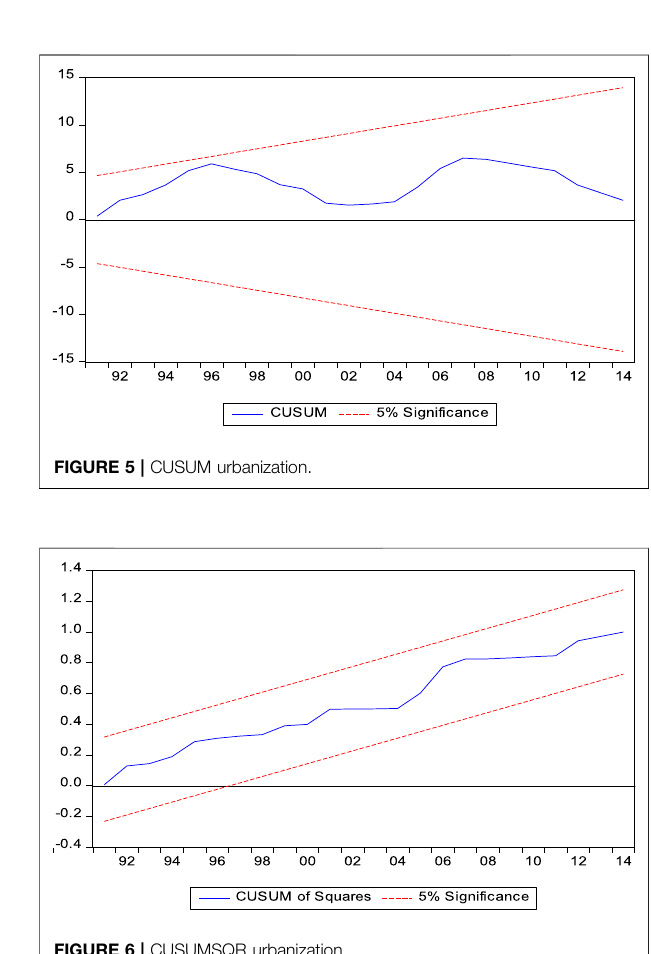
FIGURE 6 | CUSUMSQR